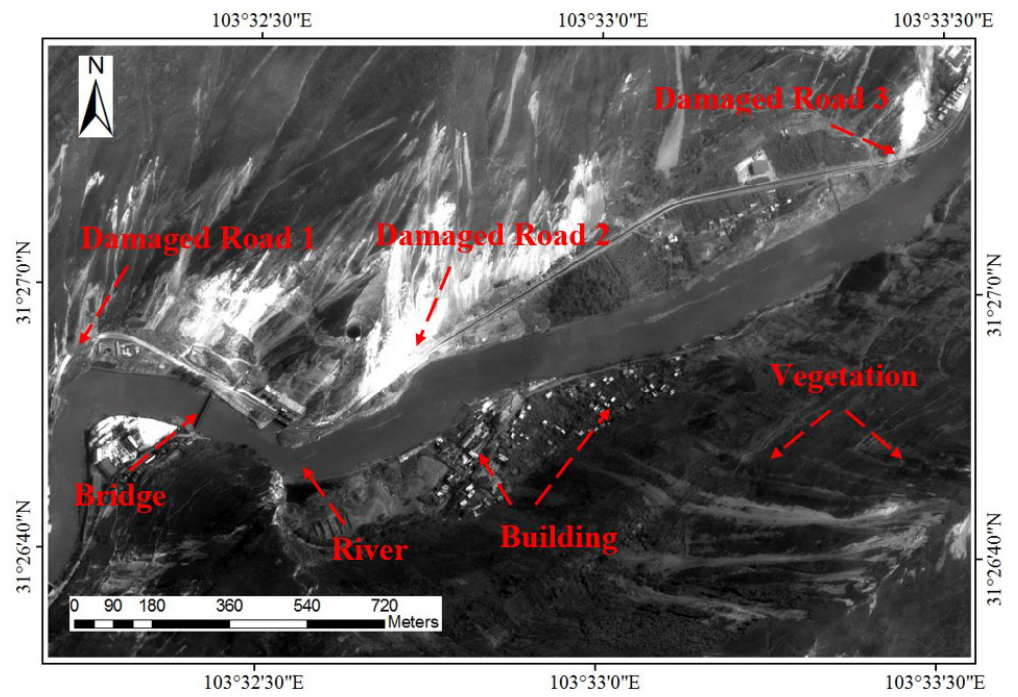
Figure 7. Image of WorldView-1 in the study